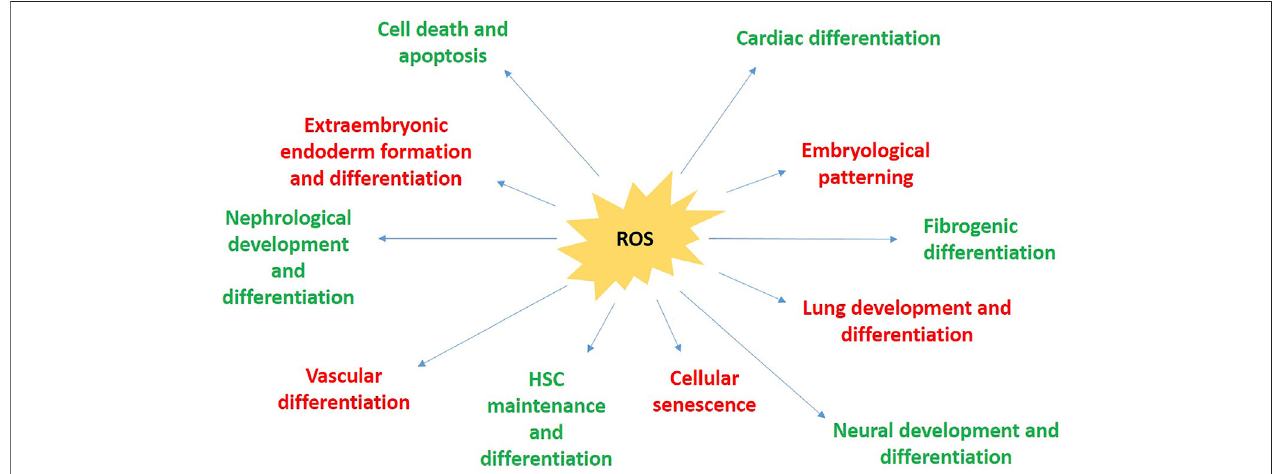
FIGURE 5 | The different areas af fl icted by the implication of ROS during perinatal